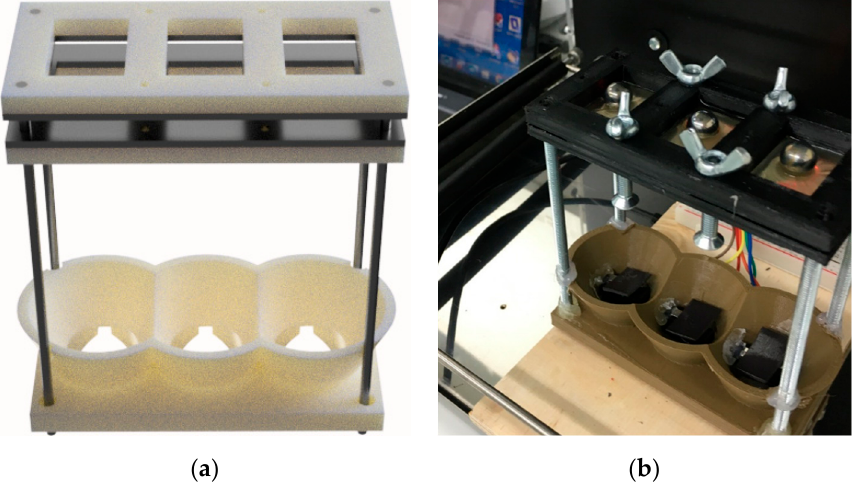
Figure 1. An in-house made slide frame and ball disintegration apparatus. ( a ) Design of the disintegration apparatus and ( b ) the disintegration test setup.